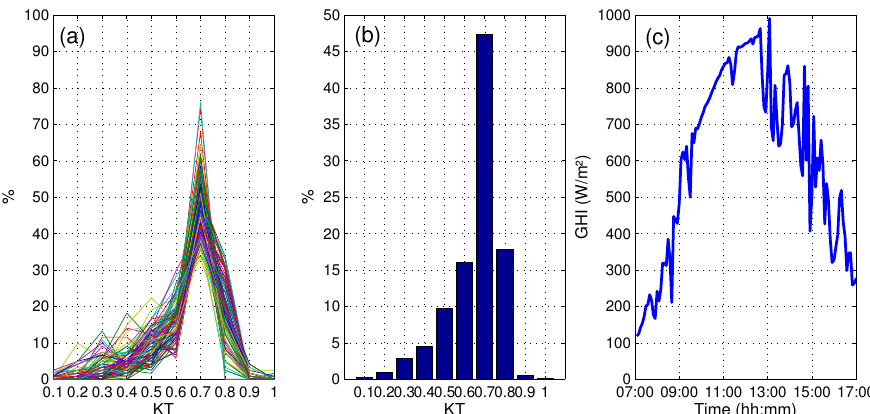
Figure 11. Class representing intermittent clear sky day event: ( a ) clearness index of 84 intermittent clear sky days; ( b ) average K t histogram of the 84 intermittent clear sky days; and ( c ) an intermittent clear sky day GHI example.